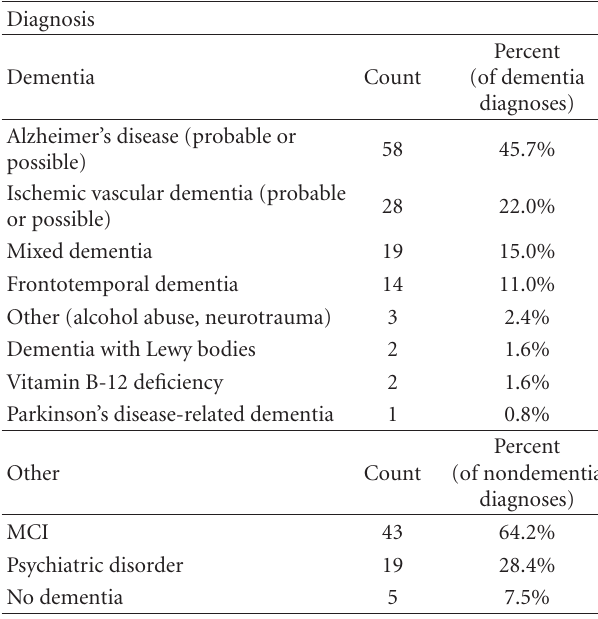
Table 2: Summary of diagnoses in the clinical